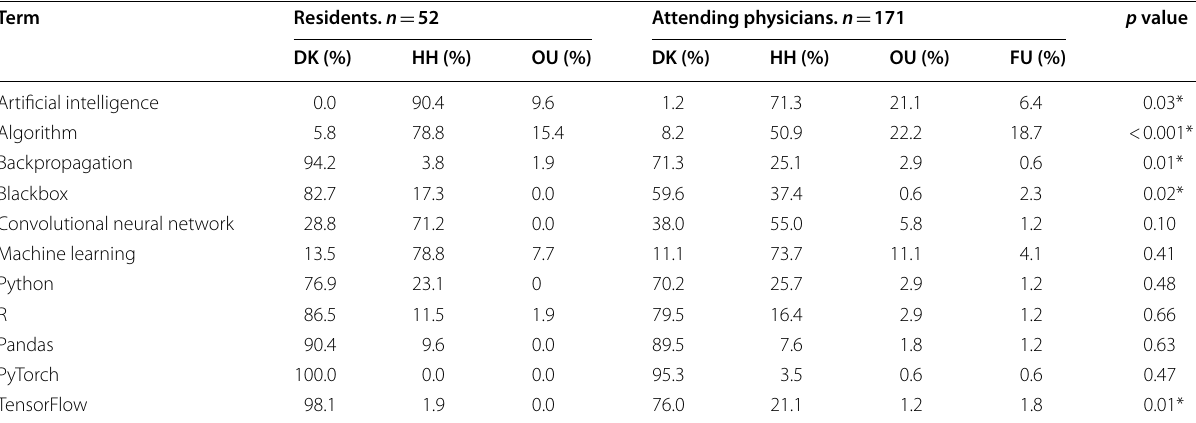
Table 3 Chi‑square analysis of terminology and technologies section